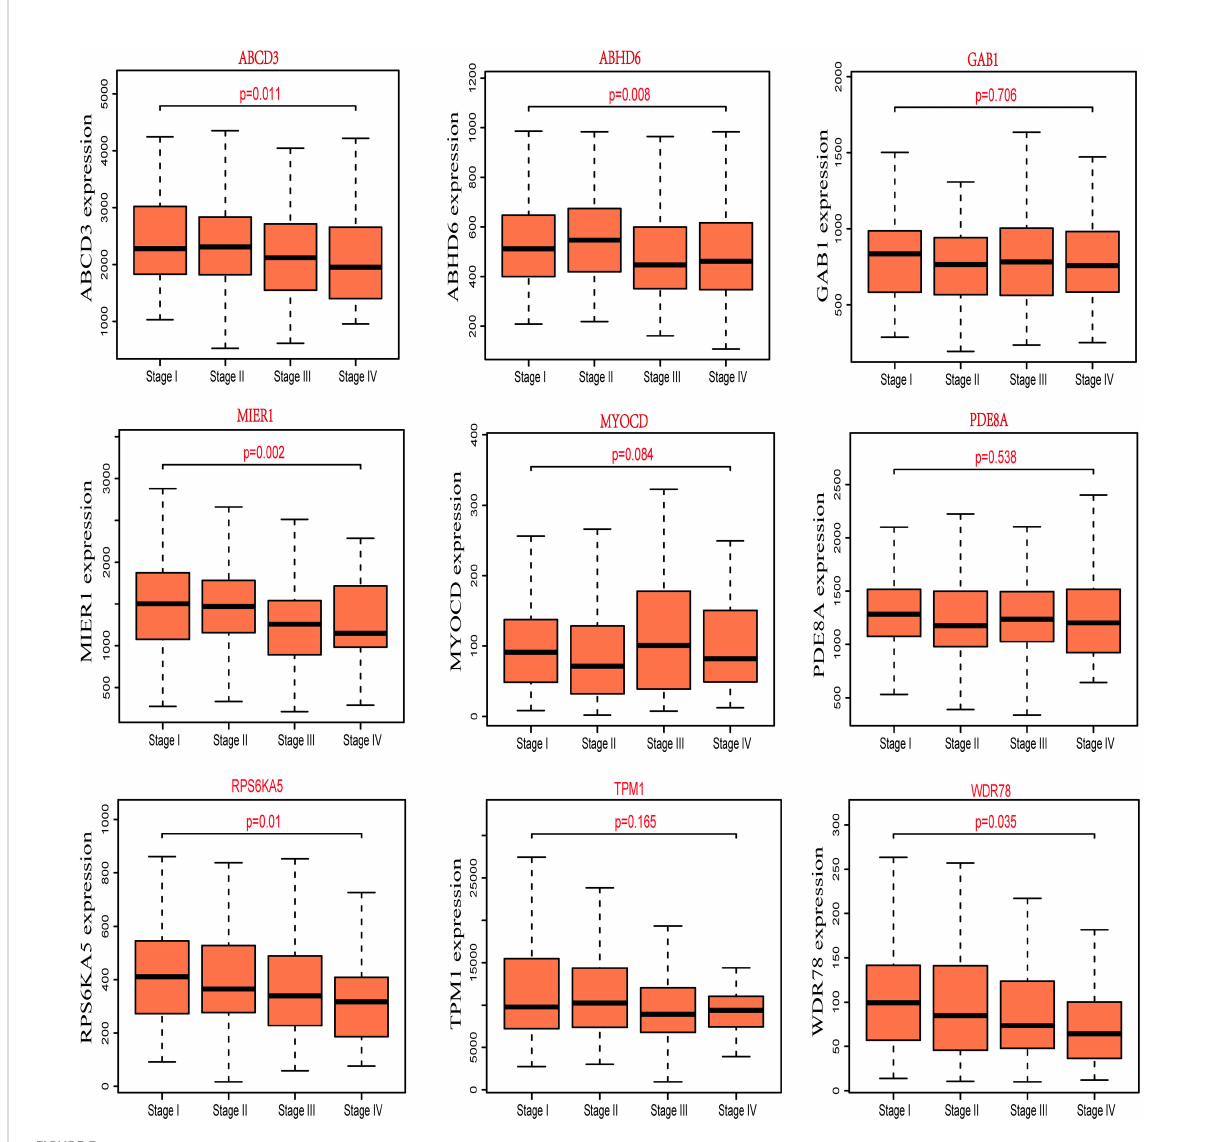
FIGURE 3 The expression of nine potential prognostic genes in different pathological stages of